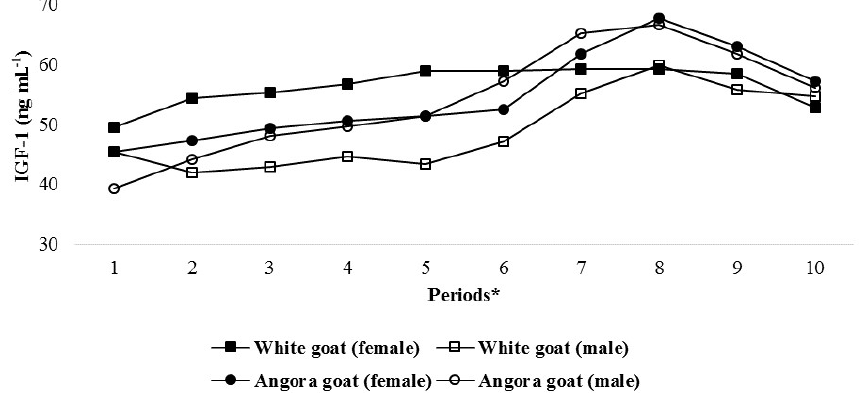
Figure 2. Changes in IGF-1 concentrations of kids during the experimental periods. ∗ The first samples (Period 1) were taken 14–15d after birth, and the other samples (periods 2–10) were then carried out at 15d